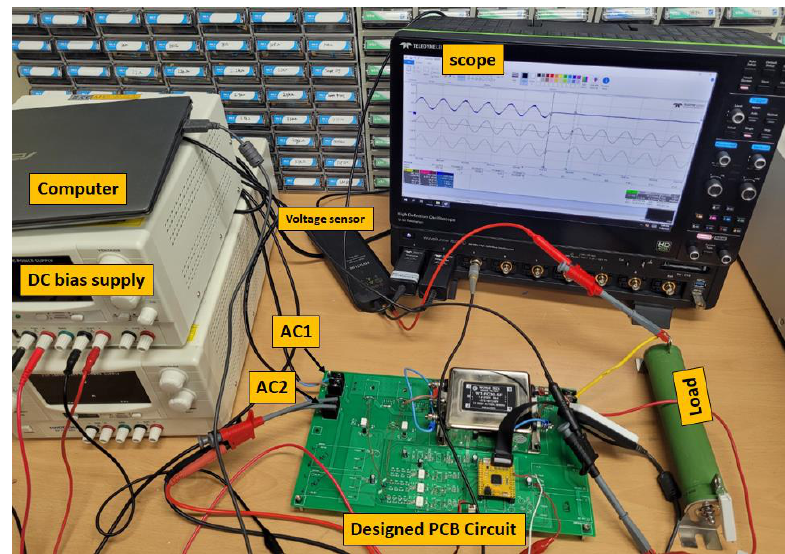
Figure 11. The experimental testing setup of the proposed SSTS switching system.